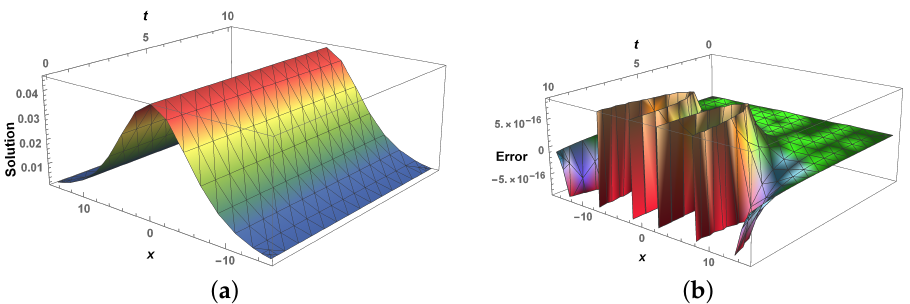
Figure 4. 3D graphical illustration of LHPM solution ( a ) and error ( b ) in Example 1 when β = 1 and k = 0.15.